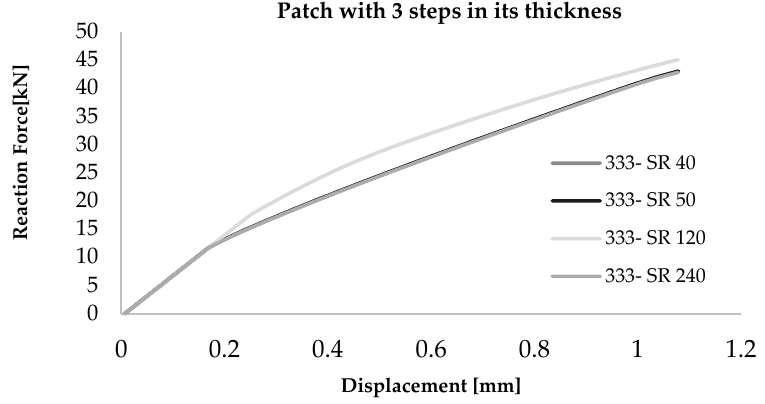
Figure 11. Displacement-Reaction Force curve for of repaired laminated with patch with 3 steps in its thickness.